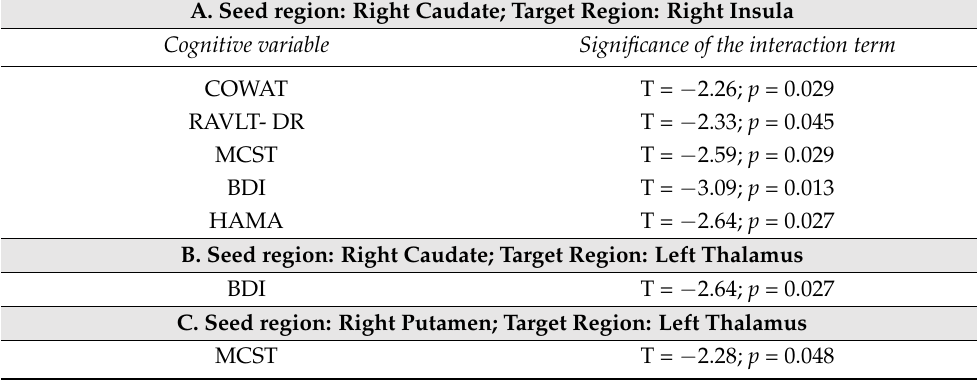
Table 6. Modulation Analysis of Structural Covariance. A. Seed region: Right Caudate; Target Region: Right Insula Cognitive variable Significance of the interaction term COWAT T = − 2.26; p = 0.029 RAVLT- DR T = − 2.33; p = 0.045 MCST T = − 2.59; p = 0.029 BDI T = − 3.09; p = 0.013 HAMA T = − 2.64; p = 0.027 B. Seed region: Right Caudate; Target Region: Left Thalamus BDI T = − 2.64; p = 0.027 C. Seed region: Right Putamen; Target Region: Left Thalamus MCST T = − 2.28; p =